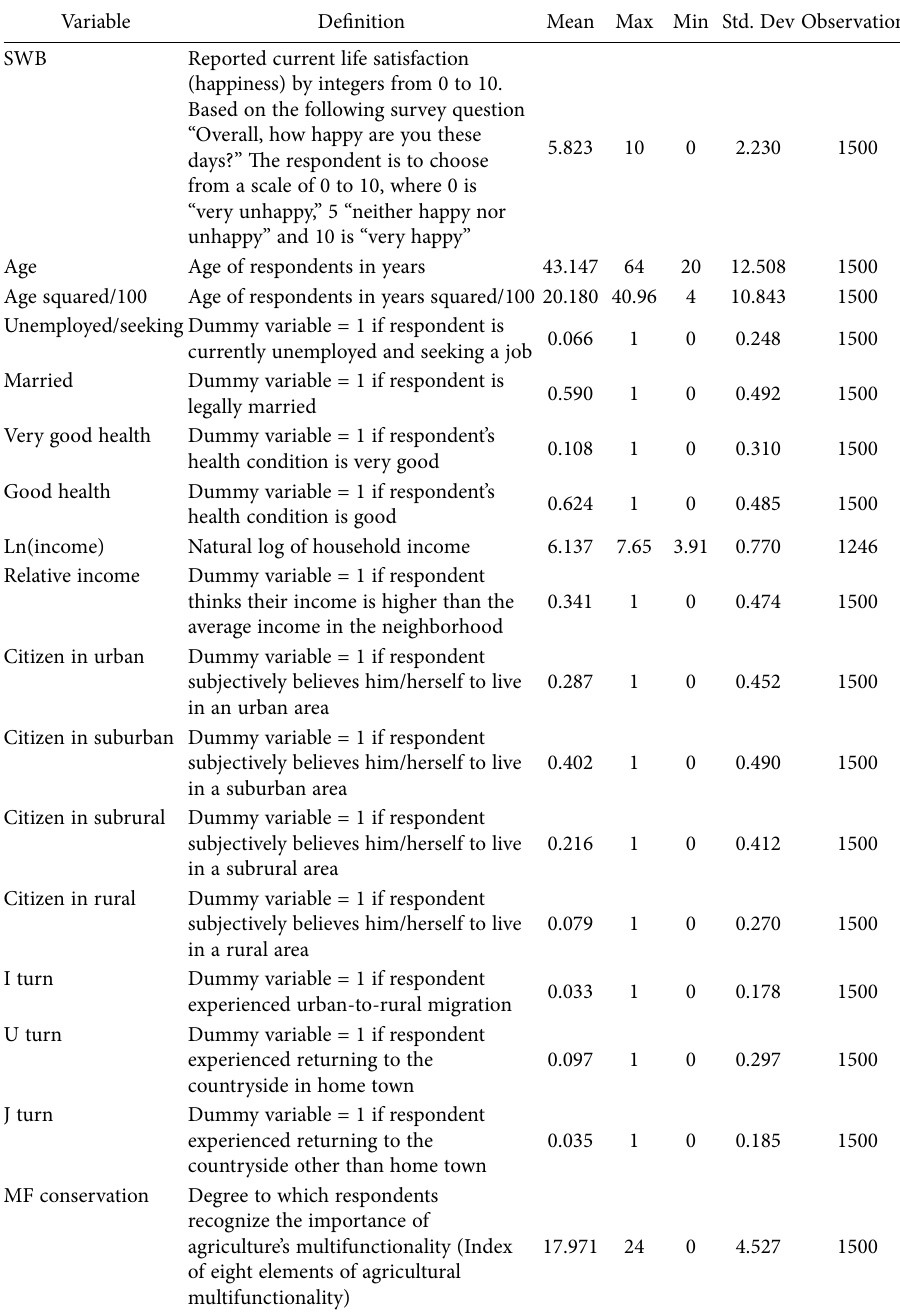
Table 1. Definition of variables and descriptive